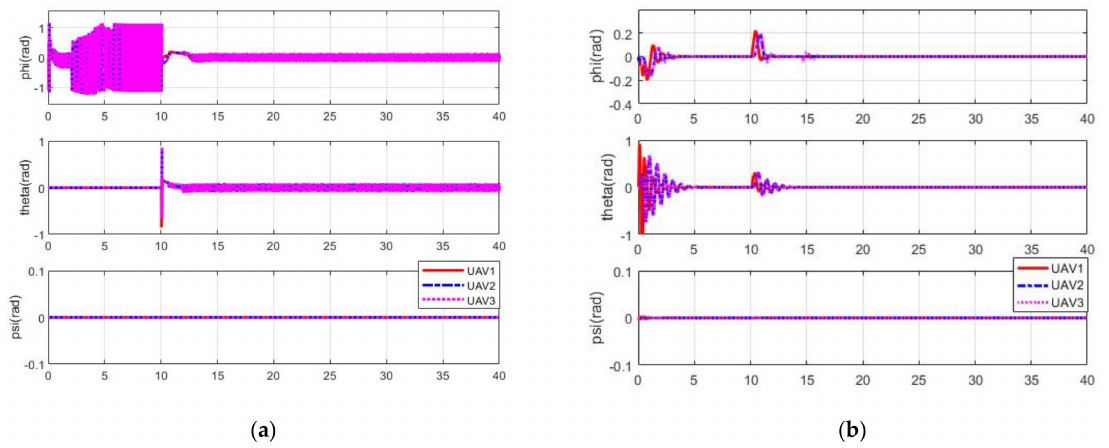
Figure 7. States of the RS for UAVs with SMC ( a ) and MPC ( b ). As can be seen from the angular response of the UAVs, MPC has less angular variation and is more stable than SMC when completing the same trajectory